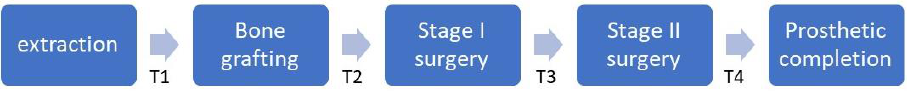
Figure 3. Definitions of different time periods. T1: Time between tooth extraction and bone grafting, T2: grafting, T2: Time between bone grafting and implant Stage I surgery, T3: Time between im- Time between bone grafting and implant Stage I surgery, T3: Time between implant Stage I surgery and plant Stage I surgery and Stage II surgery. T4: time between implant Stage II surgery and pros- Stage II surgery. T4: time between implant Stage II surgery and prosthetic completion. The time between thetic completion. The time between extraction and prosthetic completion was TT, i.e., total extraction and prosthetic completion was TT, i.e., total treatment = T1 + T2 + T3 + T4, and the time between treatment = T1 + T2 + T3 + T4, and the time between bone grafting and prosthetic completion was bone grafting and prosthetic completion was TI, i.e., implantation time = T2 + T3 + T4. TI, i.e., implantation time = T2 + T3 +